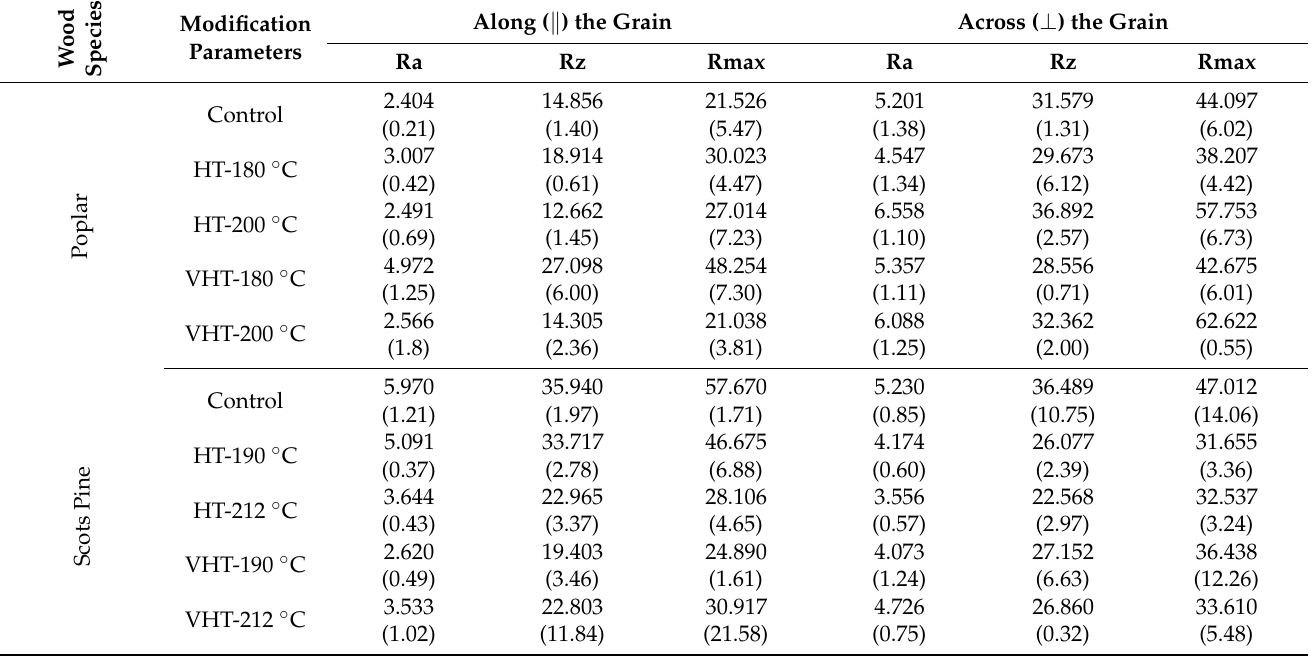
Table 2. Average surface roughness values of poplar and Scots pine after UV-IR